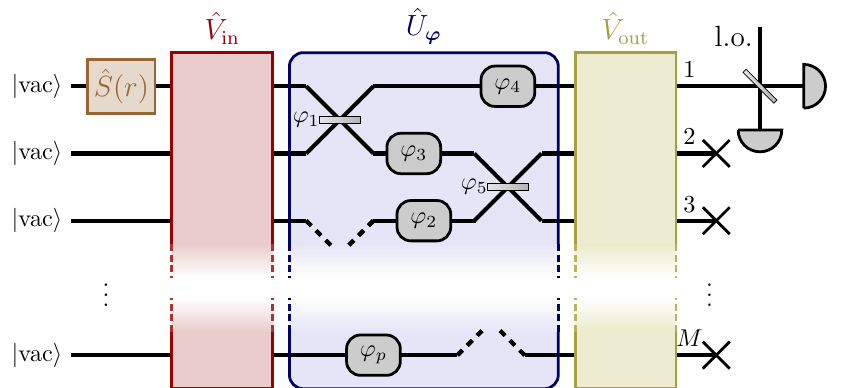
ˆ V out . The two